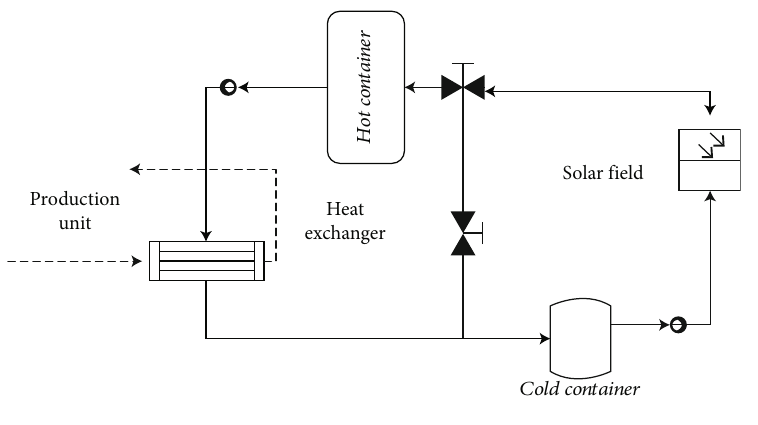
Figure 5: CSP plant.